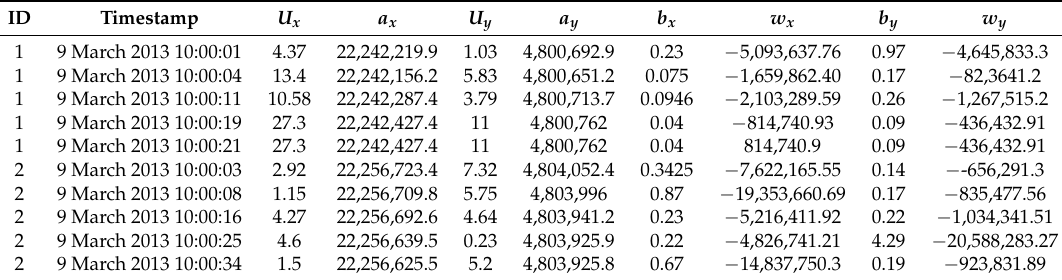
Table 2. An Overview of the Transformed Spatio-Temporal Database.